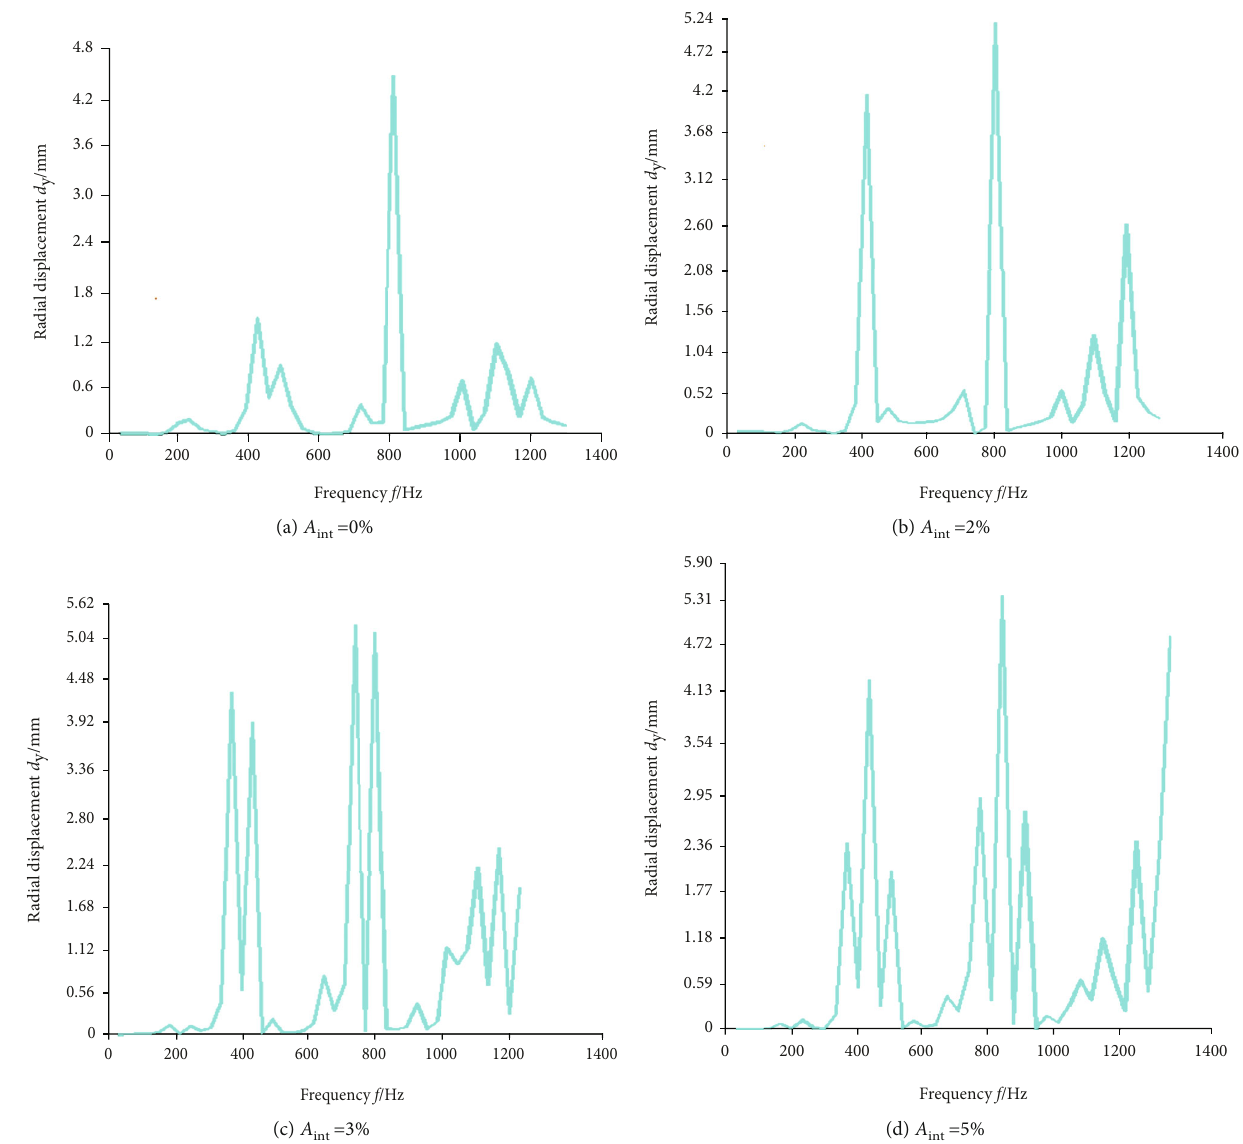
is the mistuning level; it is tuned blisk when A int